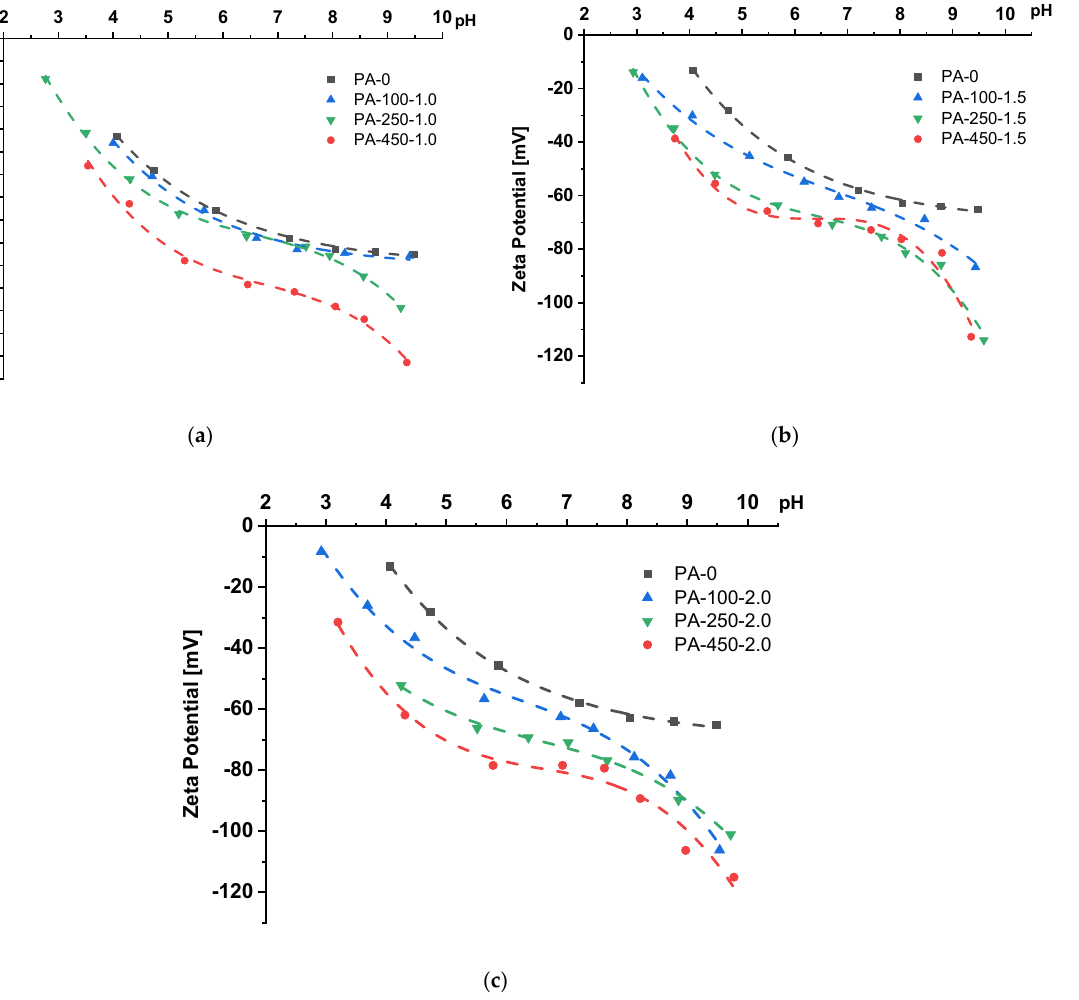
Figure 7. Dependence of ξ -potential of the surface of membrane skin layer on pH for PSF membranes obtained using additives of PAA of different concentrations, wt.%: ( a ) 1.0; ( b ) 1.5; ( c ) 2.0. For instance, at PAA concentration 2.0 wt.% in the coagulation bath, the modified membranes feature a ξ‐ potential of − 76 mV, − 101 mV and − 106 mV for PA ‐ 100 ‐ 2.0, PA ‐ 250 ‐ 2.0 and PA ‐ 450 ‐ 2.0, correspondingly. Moreover, zero fit suggests that membranes modified by PAA are characterized by an isoelectric point of around 2.5.